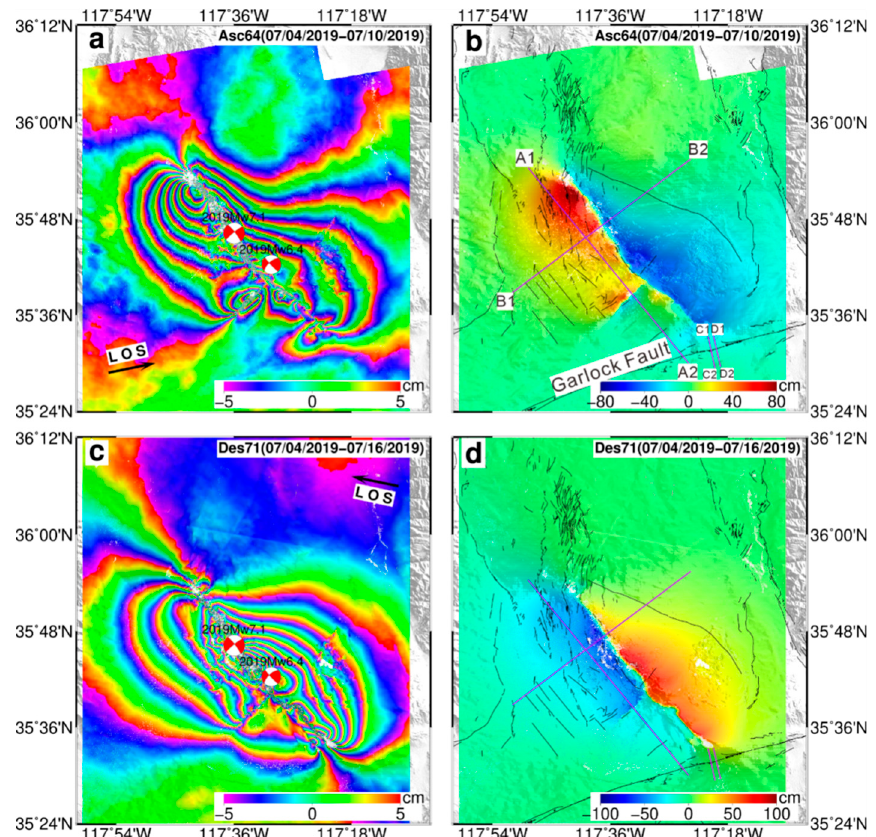
Figure 4. Ascending and descending coseismic interferograms ( a , c ) and deformation fields ( b , d ) of the 2019 Ridgecrest earthquake sequence. A color cycle in interferograms corresponds to a 10 cm deformation in line-of-sight (LOS) direction. Negative LOS displacement values in the deformation field suggest movement away from the satellite. LOS direction is indicated by the black arrow. Active faults are plotted as black thin lines. The purple lines in ( b , d ) denote the profile locations A1-A2, B1-B2, C1-C2, and D1-D2.